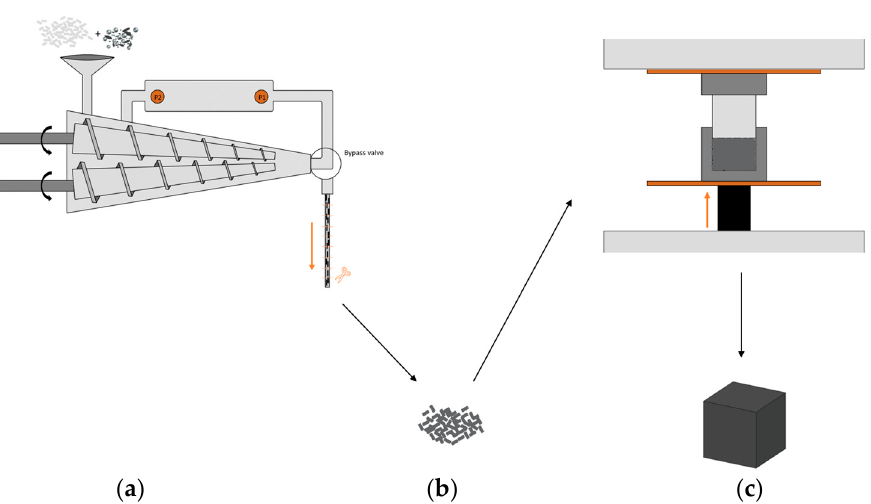
Figure 1. Overall processing scheme. ( a ) Twin-screw micro-compounder with pressure transducers (P1 and P2) integrated in a slit-capillary backflow channel. ( b ) Resulting composite pellets. ( c ) Compression moulding of these pellets in a cube-shaped sample.